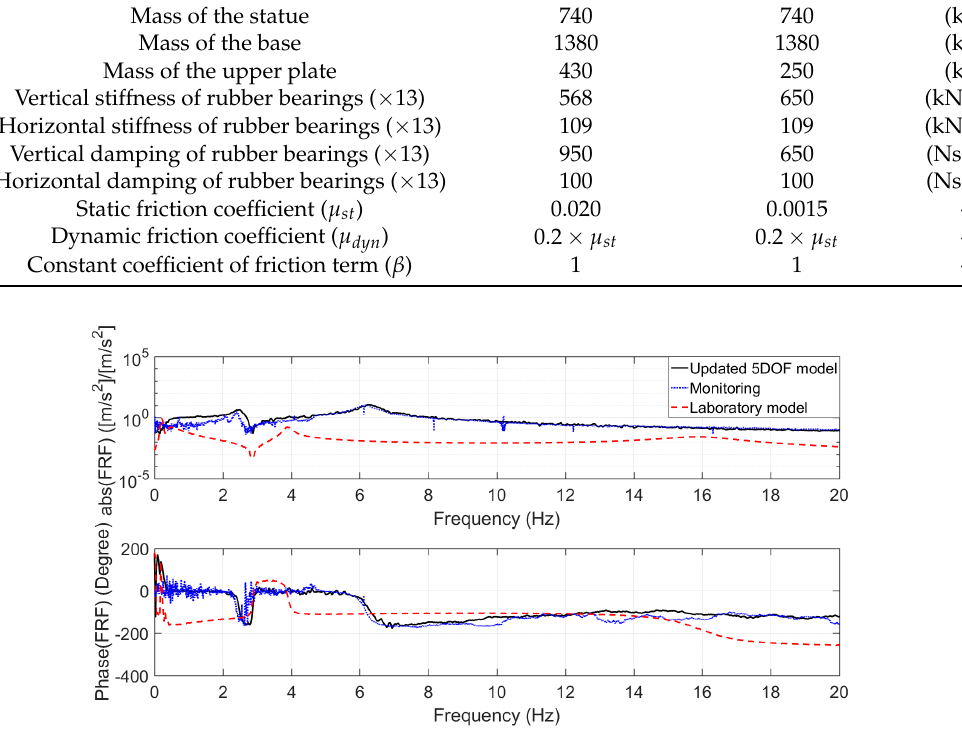
Figure 6. FRF in the horizontal direction between the seismic plate and the upper plate obtained from the updated model (black line), and the corresponding FRF obtained from the monitoring (blue dotted line) and the older model (red dashed line).